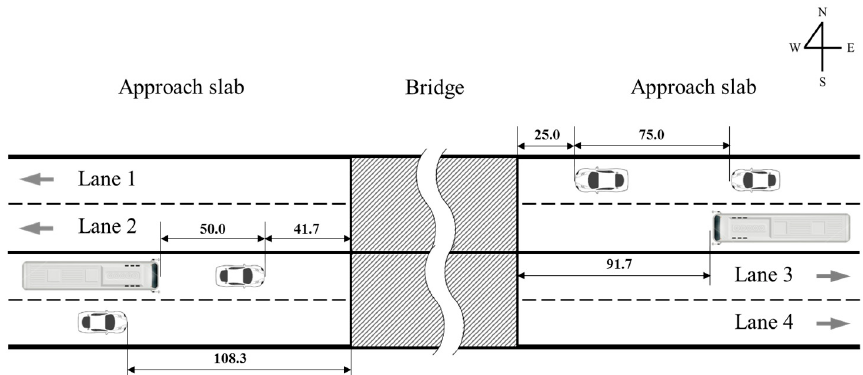
Figure 6. Example of vehicle distribution scenario for 60 km/h (unit: m).